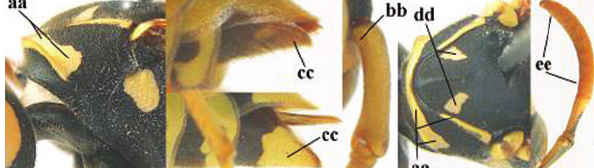
– Transverse yellow band of pronotum as wide medio-laterally as dorsolaterally or wider (aa; rarely narrowed medio-laterally and slightly widened below it) and mesoscutum usually with two yellow spots (dd); scapus entirely yellow baso-ventrally (bb), rarely slightly infuscate; colour of apical half of hypopyg- ium variable, often entirely yellow or apically brownish (cc), rarely entirely black; mesoscutum with paired yellow spots usually medium-sized to large (dd), rarely minute or absent; apical half of antenna evenly orange or yellow dorsally (ee), but more or less infuscate in P. associus ................................. 12